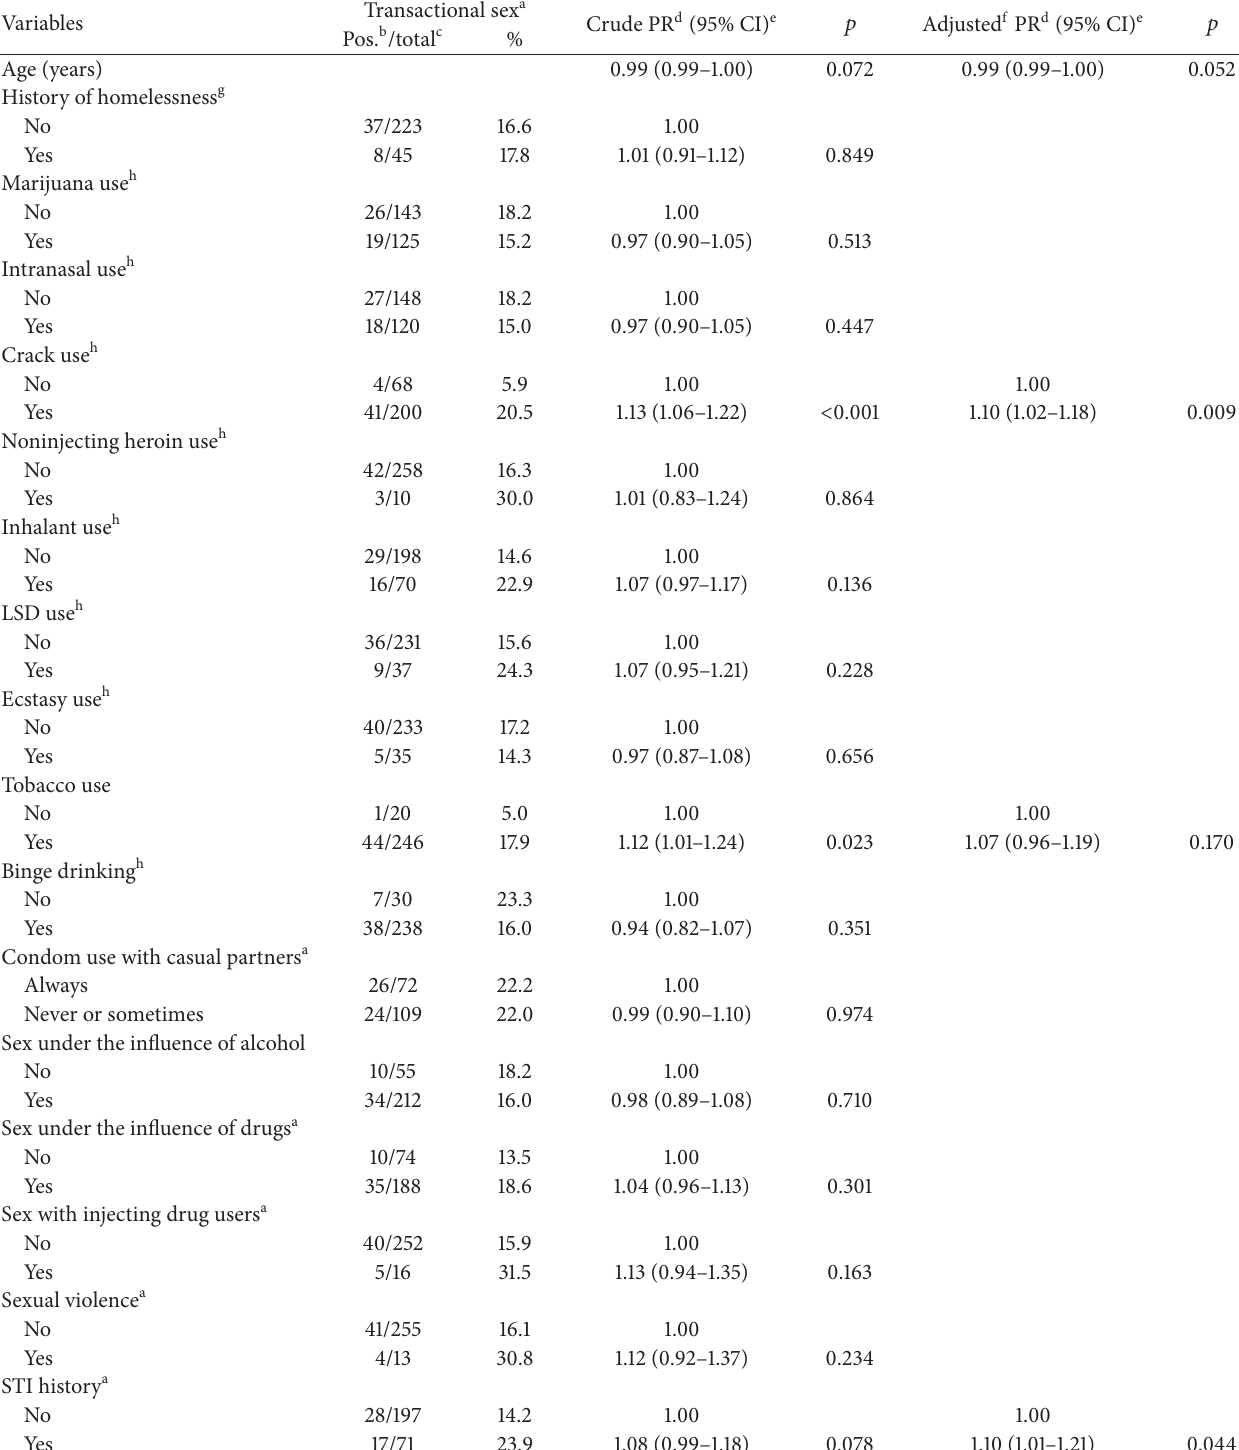
Table 1: Prevalence and risk factors for transactional sex among male noninjecting illicit drug